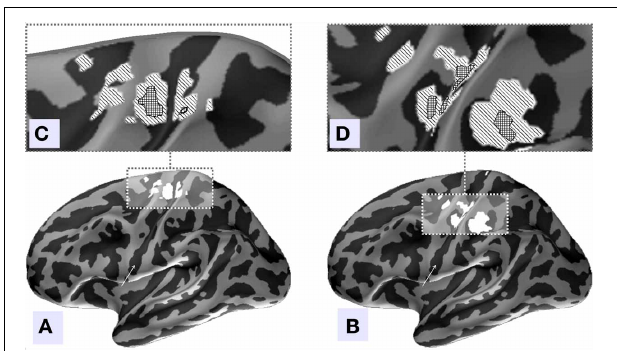
FIGURE 8 | Source localization of the two independent components with the largest amount of MI, (A) component 4, (B) component 2. Inflated surface of the left hemisphere obtained by averaging of the co-registered individual cortices of 18 subjects is shown. Light-gray areas represent gyri and dark-gray areas represent sulci. The central sulcus is indicated by arrows. Localization of the sources of both components was done via MNE approach followed by Bonferroni correction. (C,D) Illustrated patches correspond to current distribution thresholded at significance level of p < 0 . 001. (C) We can see that in agreement with our hypothesis the topography of the independent component with the largest amount of MI predominantly localizes anterior to the central sulcus and may represent the M1 zone. (D) The second component’s sources localize to the post-central fissure and in the depth of the central fissure inferior to the omega shaped zone.